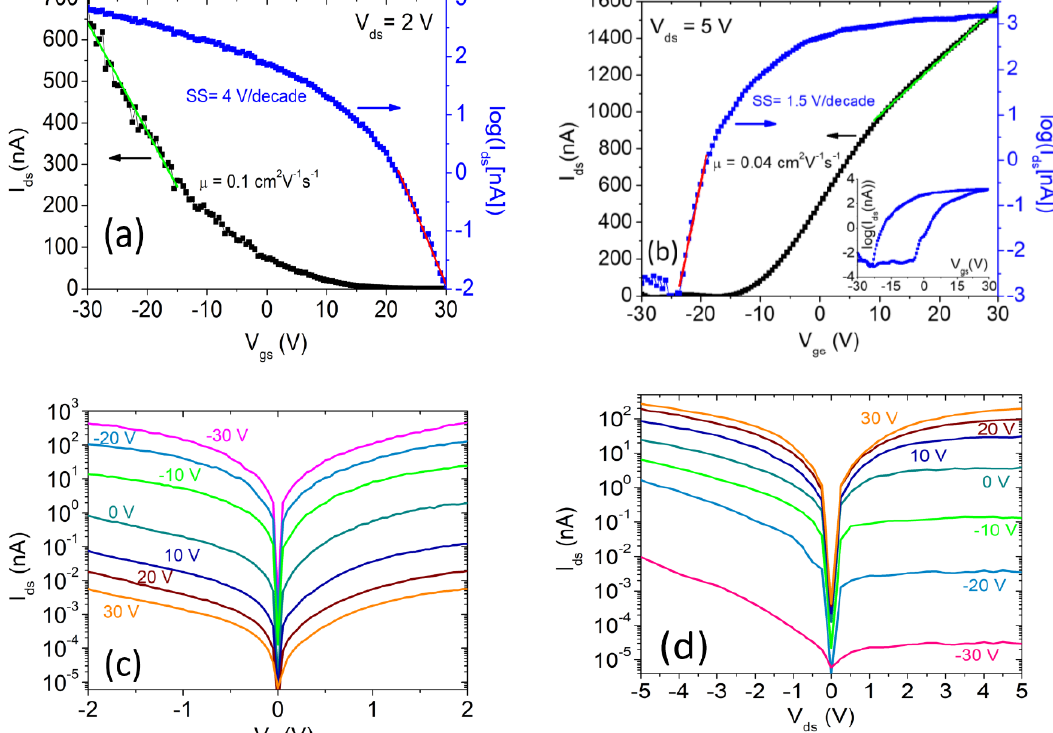
Figure 2. Transfer characteristics ( I ds − V gs curves) obtained at a drain voltage bias V ds = 2 V for the device covered with PMMA ( a ) and after the removal of PMMA ( b ) at V ds = 5 V . The inset shows a complete cycle with the gate voltage V gs swept forward and backward. Output characteristics ( I ds − V ds curves) at different gate voltages for the device with ( c ) and without ( d ) PMMA. For the uncovered device, the drain bias was increased from V ds = 2 V to V ds = 5 V to better characterize the above-threshold region.